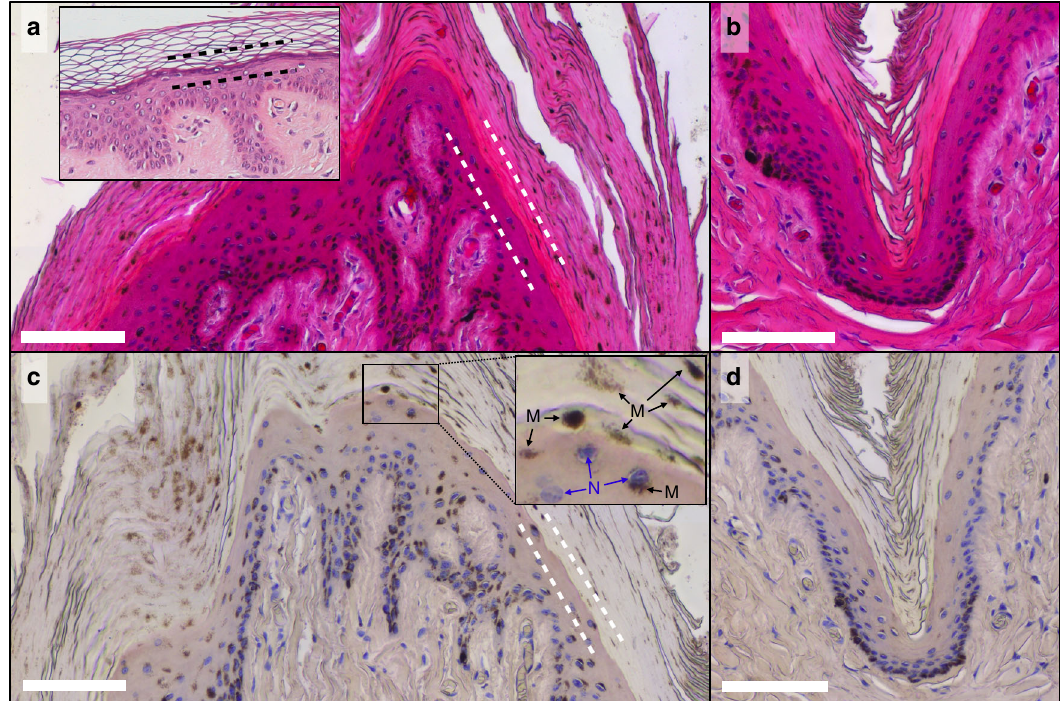
Fig. 3 The epidermis of African elephants exhibits orthokeratosis and lacks keratohyalin granules. a , b Skin sections stained with haematoxylin and eosin from the top of a papillae ( a ) and from a trough ( b ). The lack of haematoxylin staining close to the transition from the viable epidermis to the stratum corneum (dashed lines) suggests that keratohyalin granules are not present in the animal ’ s epidermis (inset, public domain image: similarly stained human skin section shows, between dashed lines, the strong haematoxylin staining due to the presence of keratohyalin granules). Orthokeratosis is equally perceivable: the stratum corneum is thick but otherwise normal looking. Similar morphological features are often observed in human patients with ichthyosis vulgaris . The inset in Fig. 3a is an adaptation of the image created by Kilbad available in the public domain, sourced from https://en.wikipedia.org/wiki/File: Normal_Epidermis_and_Dermis_with_Intradermal_Nevus_10×.JPG. c , d Same as a , b , but only haematoxylin staining was applied for better contrast. Again, the absence of keratohyalin granules is clearly visible. The inset of c indicates that dark spots in the stratum corneum are not viable nuclei (N) but clusters of melanin granules (M). Scale bars: 100 μ